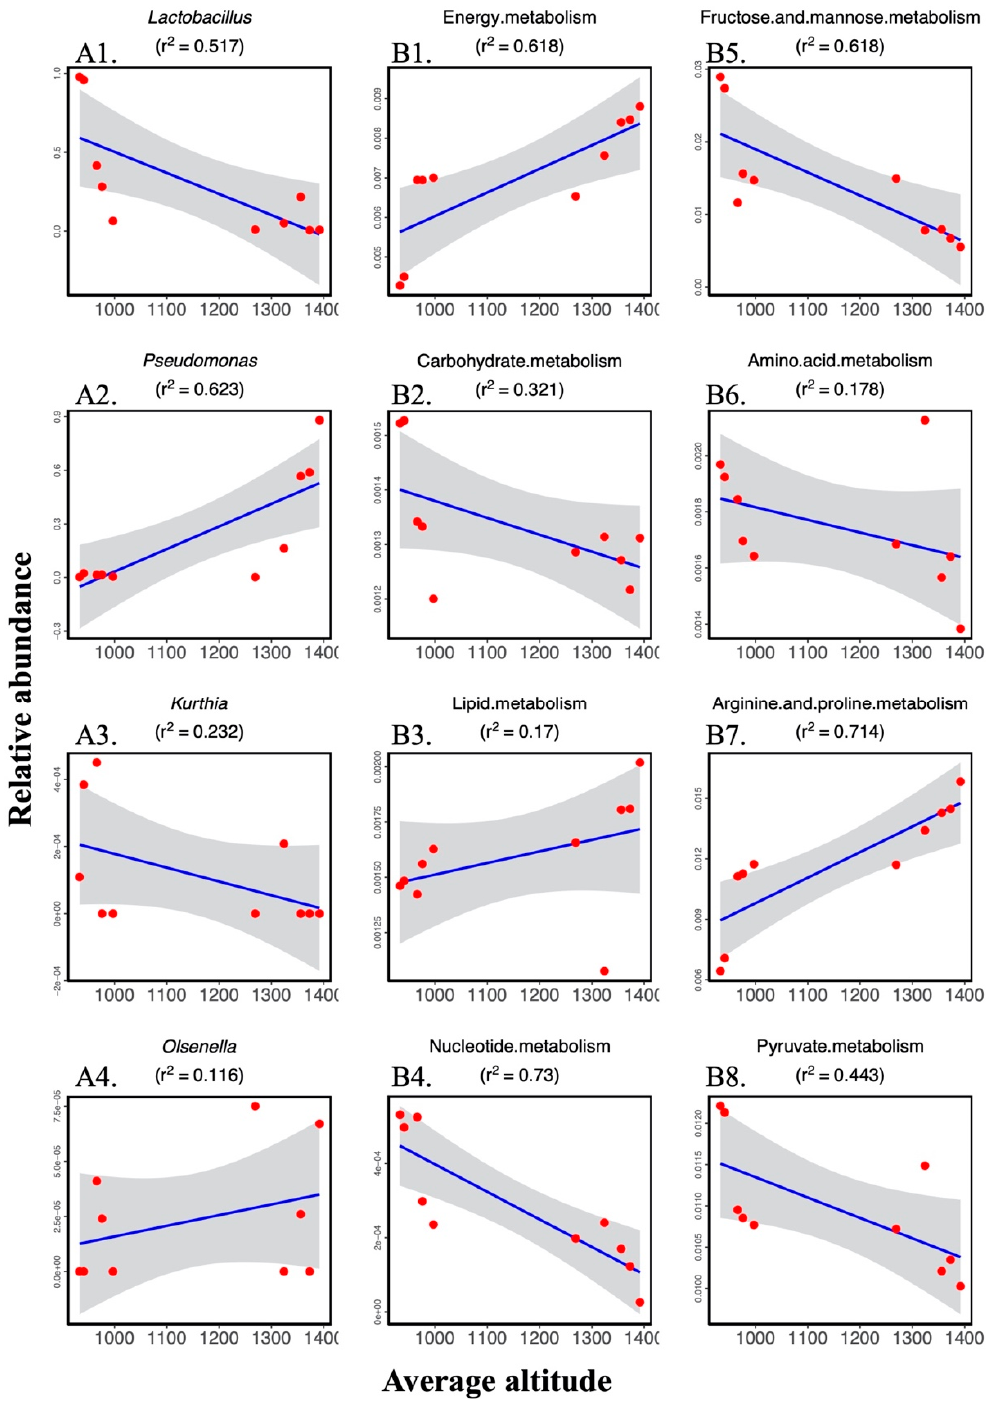
Figure 5. ( A ) Linear regression of the relative abundance of bacterial genera and altitude ((A1) Lactobacillus; (A2) Pseudomonas; (A3) Kurthia; (A4) Olsenella). ( B ) Linear regression of proportion of KEGG pathway modules at level 3 and altitude ((B1) Energy metabolism; (B2) Carbohydrate metabolism; (B3) Lipid metabolism; (B4) Nucleotide metabolism; (B5) Fructose and mannose metabolism; (B6) Amino acid metabolism; (B7) Arginine and proline metabolism; (B8) Pyruvate metabolism).